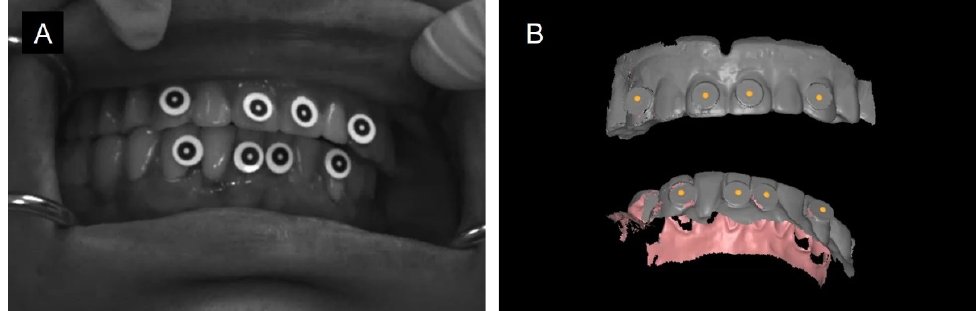
Figure 1. ( A ) Target materials were attached to the anterior teeth of the patient’s old denture and antagonist arch. ( B ) Anterior regions of both arches were scanned using an intraoral scanner to detect the targets.